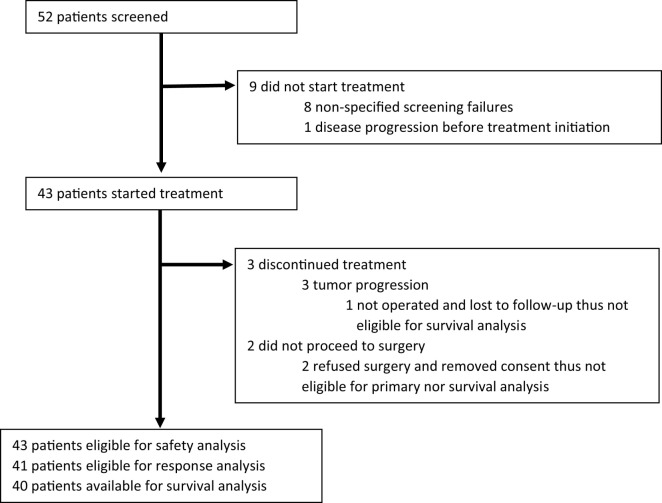
Patients flowchart.